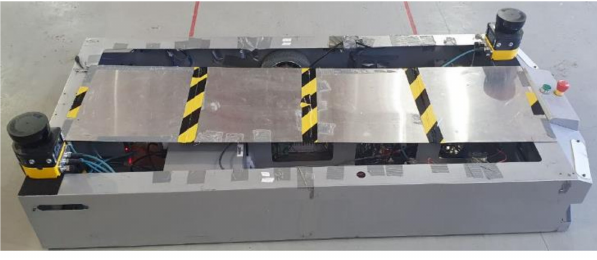
Figure 5. The studied SGV. Table 3. Experimental working cycle